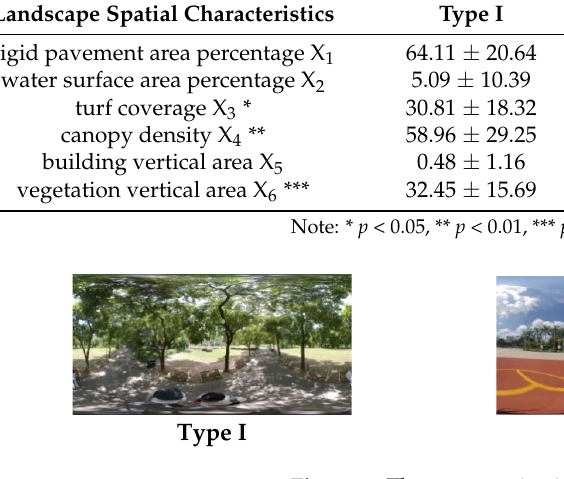
Figure 4. Clustering map of morning points. Table 2. Landscape spatial characteristics of the three types of morning points.